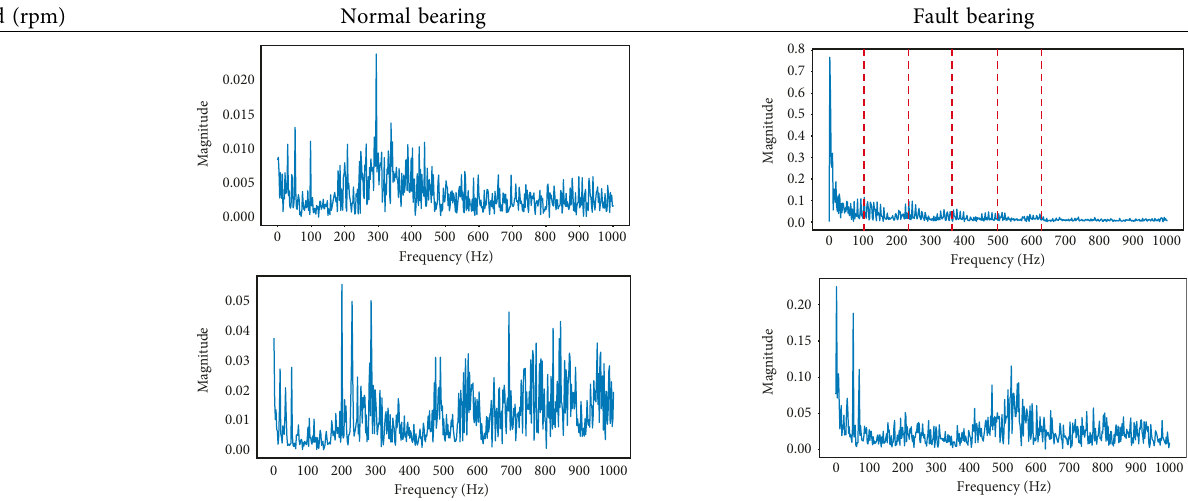
Table 7: Frequency domain diagram of vertical acceleration signal.